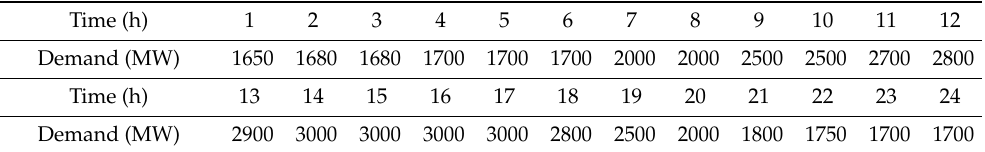
Table 8. Demand forecasting over 24